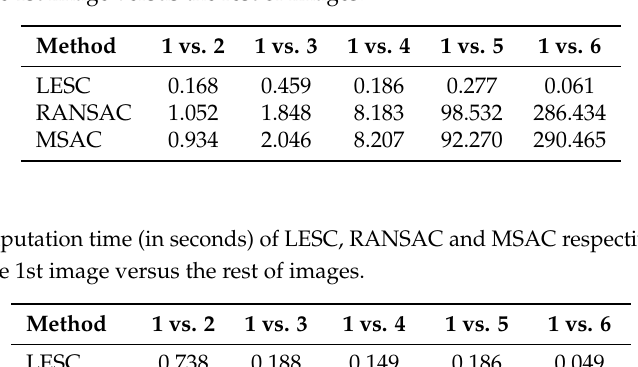
Table 9. The computation time (in seconds) of LESC, RANSAC and MSAC respectively on the Wall sequence using the 1st image versus the rest of images.